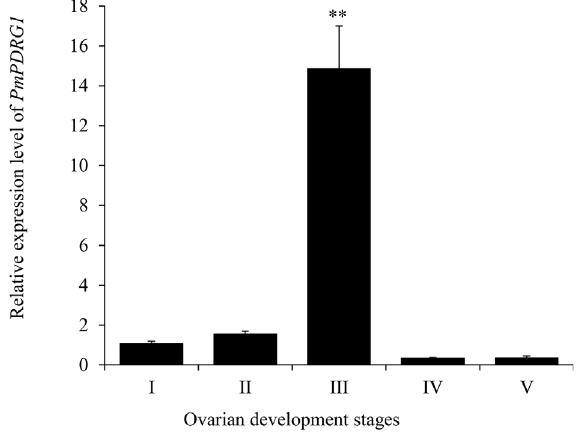
Figure5 -Relativeexpressionlevelsof PmPDRG1 mRNAatdifferentde - velopmental stages of the ovaries. I, ovogonium stage; II, chromatin nu- cleolus stage; III, perinucleolus stage; IV, yolky stage; and V, cortical rod stage; Vertical bars represent the mean (cid:2) SD (n =5). ** P <